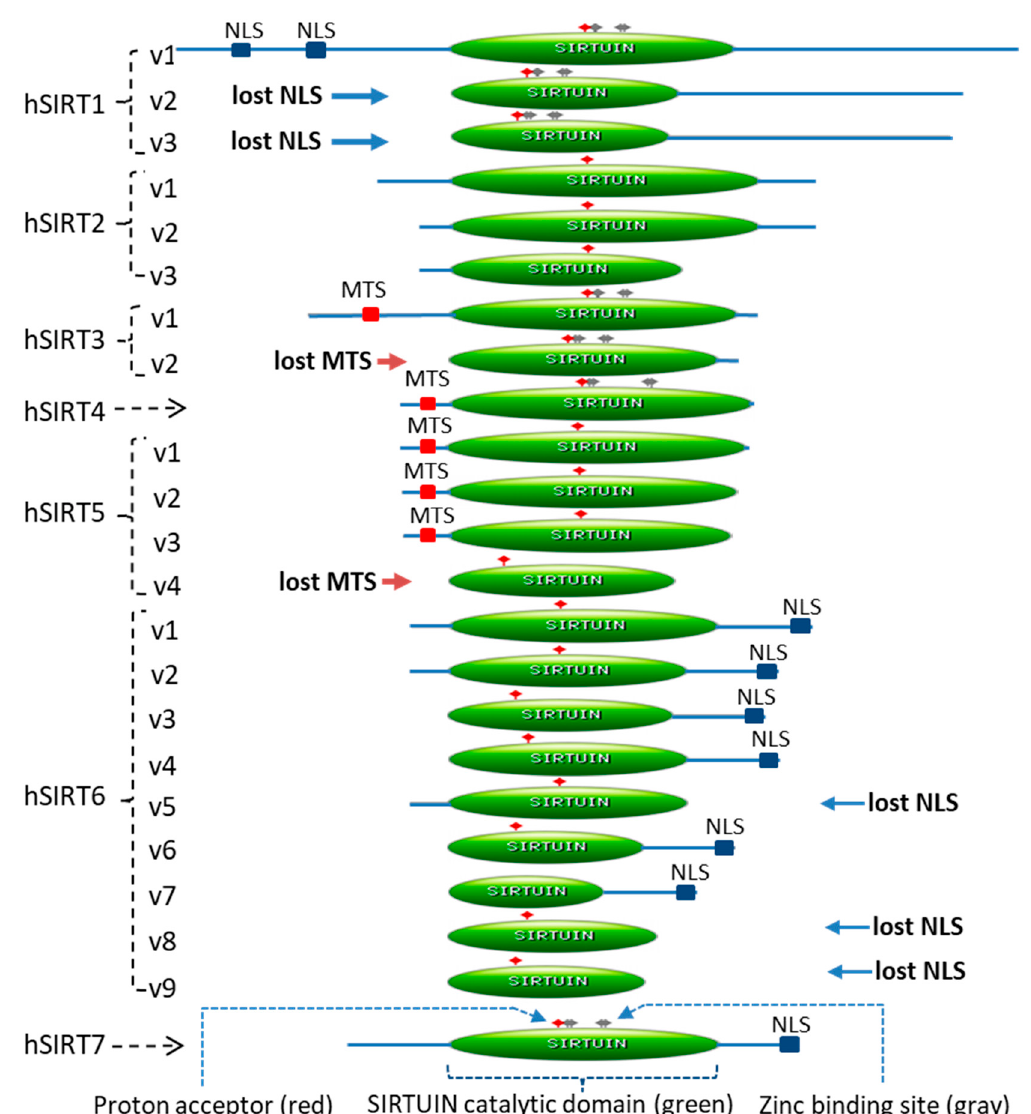
Figure 1. The twenty-three isoforms of human sirtuin genes (SIRT1-7). A schematic diagram of 23 isoforms. Most sirtuin isoforms lost part of the protein domains, which included part of the N- or C-terminus, catalytic domain (in green color), nuclear localization signal (NLS), and mitochondrial targeting signal (MTS). The functional domain analysis was performed using the “ScanProsite” software [16], which showed the catalytic domain “SIRTUIN” in green color, the “Proton acceptor” in red color, and the “Zinc binding site” in gray color. Here the SIRT7 protein was used as an example for detailed illustration, but the functional domain and sites are similar among all 23 isoforms.